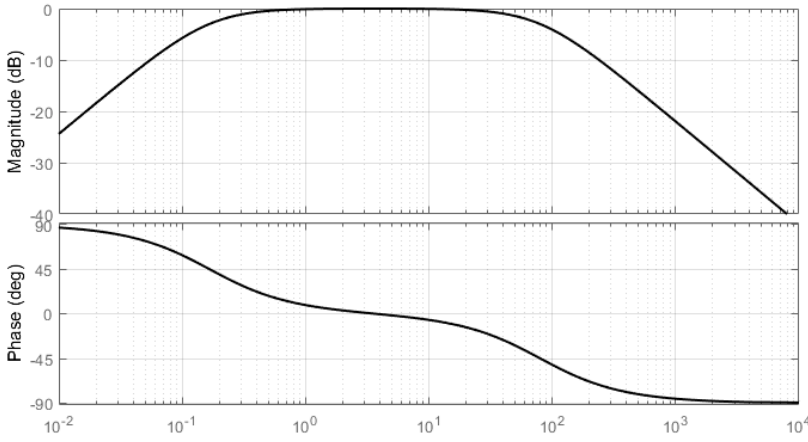
Figure 5. The Bode diagram of the filter .